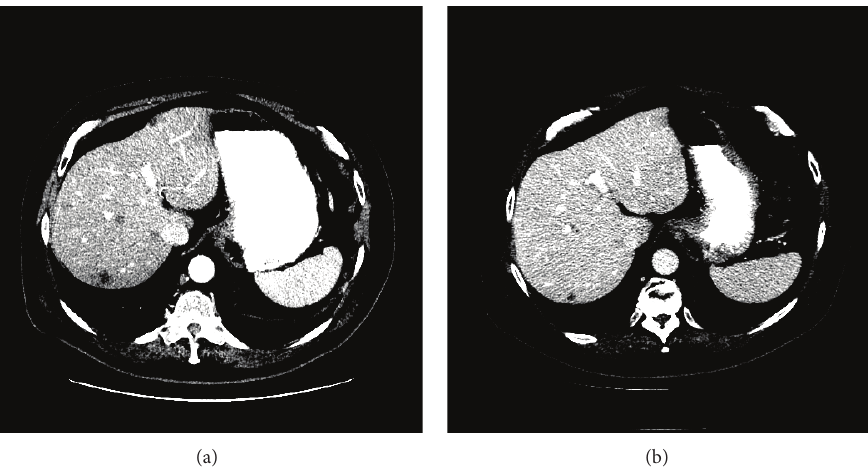
Figure 2: CT of the abdomen in case #3 revealed liver metastases (a) before the treatment and (b) after 17 months of